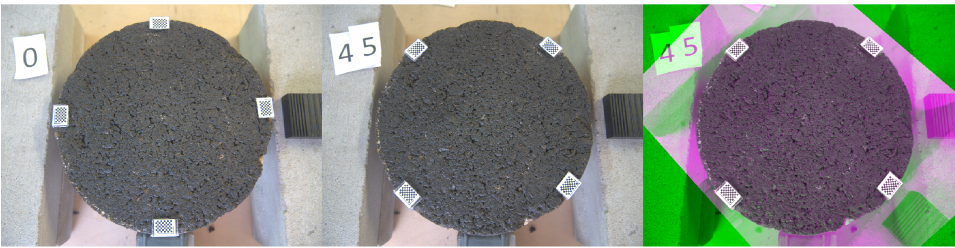
Figure 9. Triplet image. Left: 0th position. Centre: 45th position. Right: Overlapped after transfor- mation 0th →